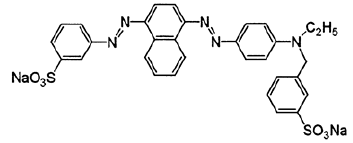
Figure 1. Structure of Acid Red 119 dye.